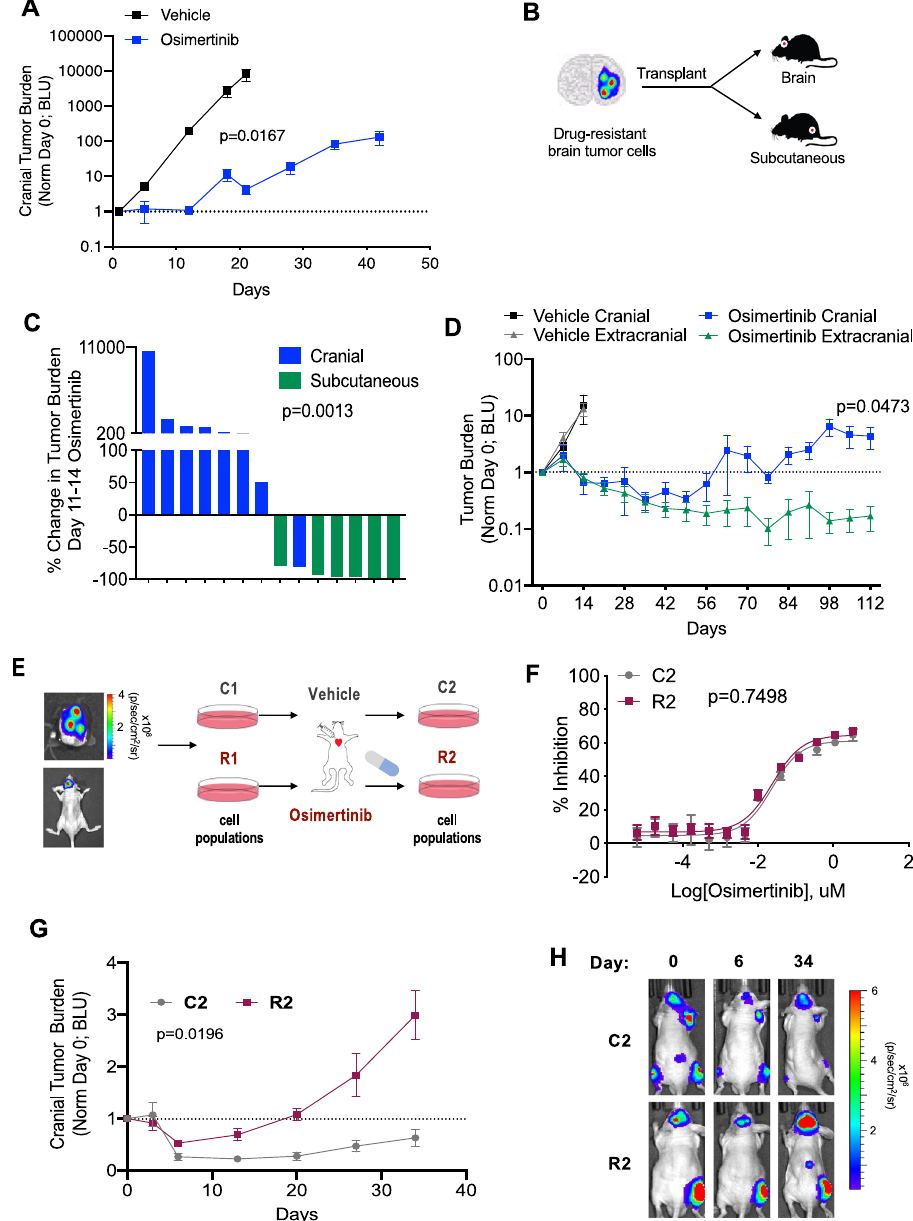
Fig. 1 | Exposure to the brain TME promotes osimertinib persistence and resistance. A H1975 cells were injected into the cranium of mice and then treated with vehicle or osimertinib three days later. Tumor burden was then measured by bioluminescence imaging (BLI) and bioluminescent units (BLU) plotted over time. N =3animalsforvehicle,and N =7animalsforosimertinib.Datapresentedasmean values +/ − SEM. P -value calculated based on area under the curve (AUC) by Mann – Whitney (two-sided). B Experimental design in which osimertinib-resistant H1975braintumorcellswerere-transplanteddirectlyintothebrainsorhind fl anks of treatment-naïve mice. C Waterfallplot of data from the experiment in B . Shown are % tumor burden changes of transplanted cells from Day 0 to Day 10 – 14 of treatment with osimertinib. Cranial tumor burden is determined by brain BLI and subcutaneoustumorburdenisdeterminedby fl anktumorvolume. N =8micewith cranialtransplant,and N =6micewithsubcutaneoustransplant. P -valuecalculated by Mann – Whitney (two-sided). D PC9-BrM4 cells were injected into the arterial circulation of mice. Animals were then treated with vehicle or osimertinib after